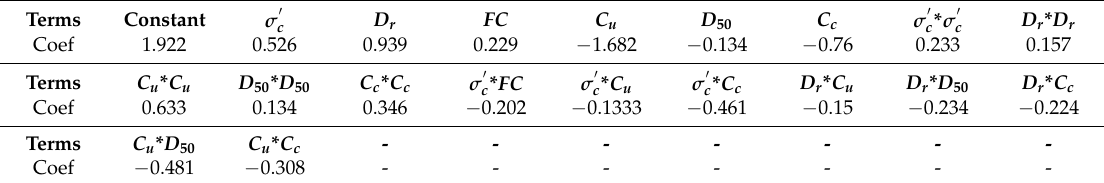
Table 8. RSM equation with the DOE of the BB design, based on the second ANN model (R 2 = 96.49%, R 2 [adjust] = 94.52%).